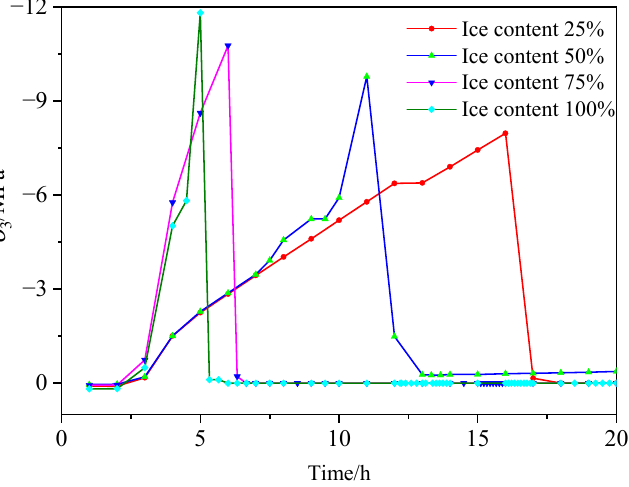
Figure 13. The evolution of the minimum principal stress of typical elements under different ice contents.